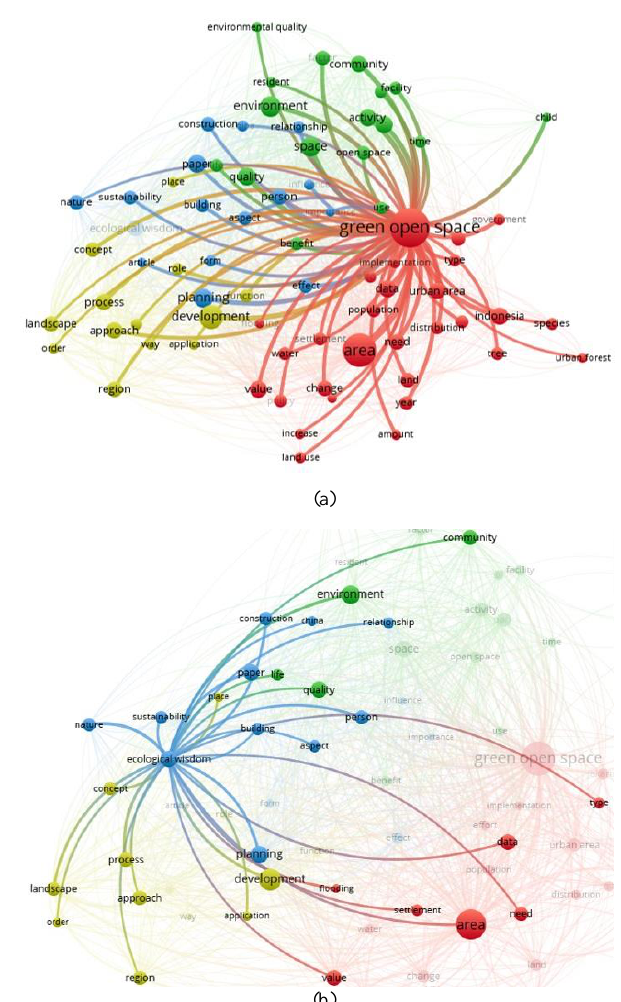
Figure 5. Green Open Space and Ecological Wisdom Network